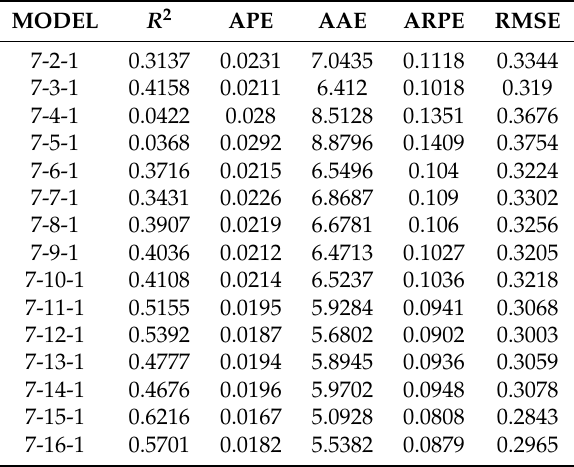
Table 3. Error measures for different network